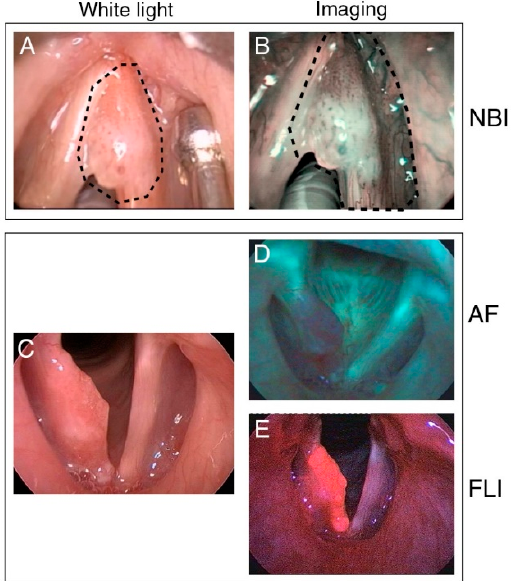
Figure 2. Clinical examples of fluorescence-based imaging modalities in laryngeal cancer. ( A ) White light image of cT1a laryngeal squamous cell carcinoma of the anterior third of the right vocal fold and its presumptive resection margins (dotted line) compared to ( B ) Narrow-Band Imaging (NBI), showing thick dark spots typically associated with carcinoma in situ. The planned superficial resection margins of type II cordectomy ( A ) were extended on the basis thereof ( B ). ( C ) White-light laryngoscopy demonstrating a bulging small squamous cell carcinoma of the right vocal fold with extension from the anterior commissure to the vocal process. ( D ) Autofluorescence (AF) laryngoscopy shows a reddish-violet fluorescence of the cancerous right vocal fold and green fluorescence of the normal mucosa. ( E ) Protoporphyrin IX accumulates in the cancerous tissue demonstrating a bright orange-red fluorescence signal during indirect laryngoscopy. A and B are adapted and reproduced from Garofolo et al. [18], by permission of SAGE Publications, Inc. C–E are adapted and reproduced from Arens et al. [35], by permission of Springer Nature.